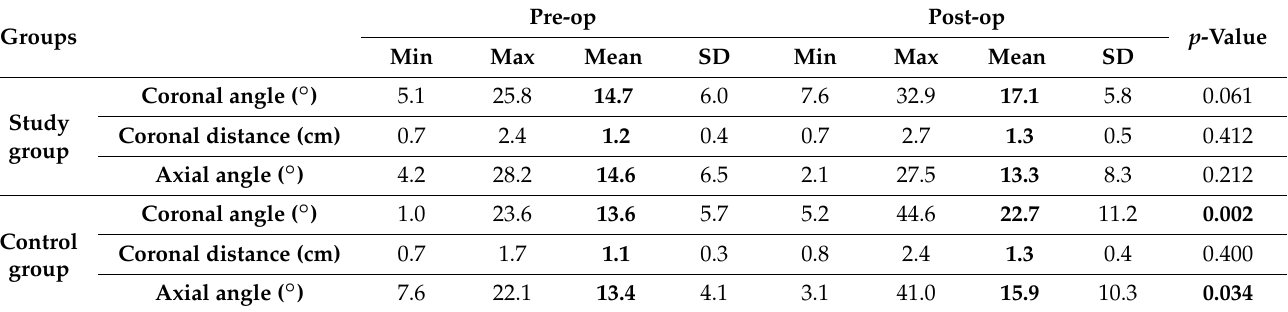
Table 1. Measurements for the study group ( n = 18) and control group ( n = 16) pre- and post-op.